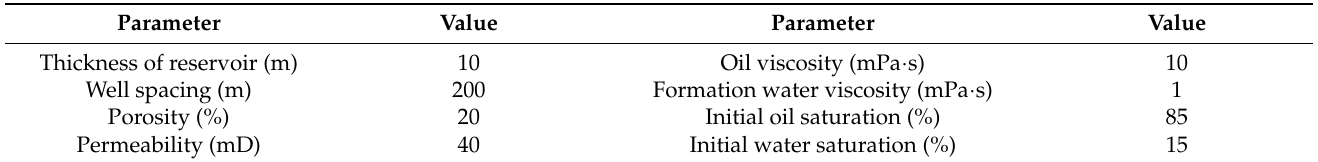
Table 1. Reservoir basic